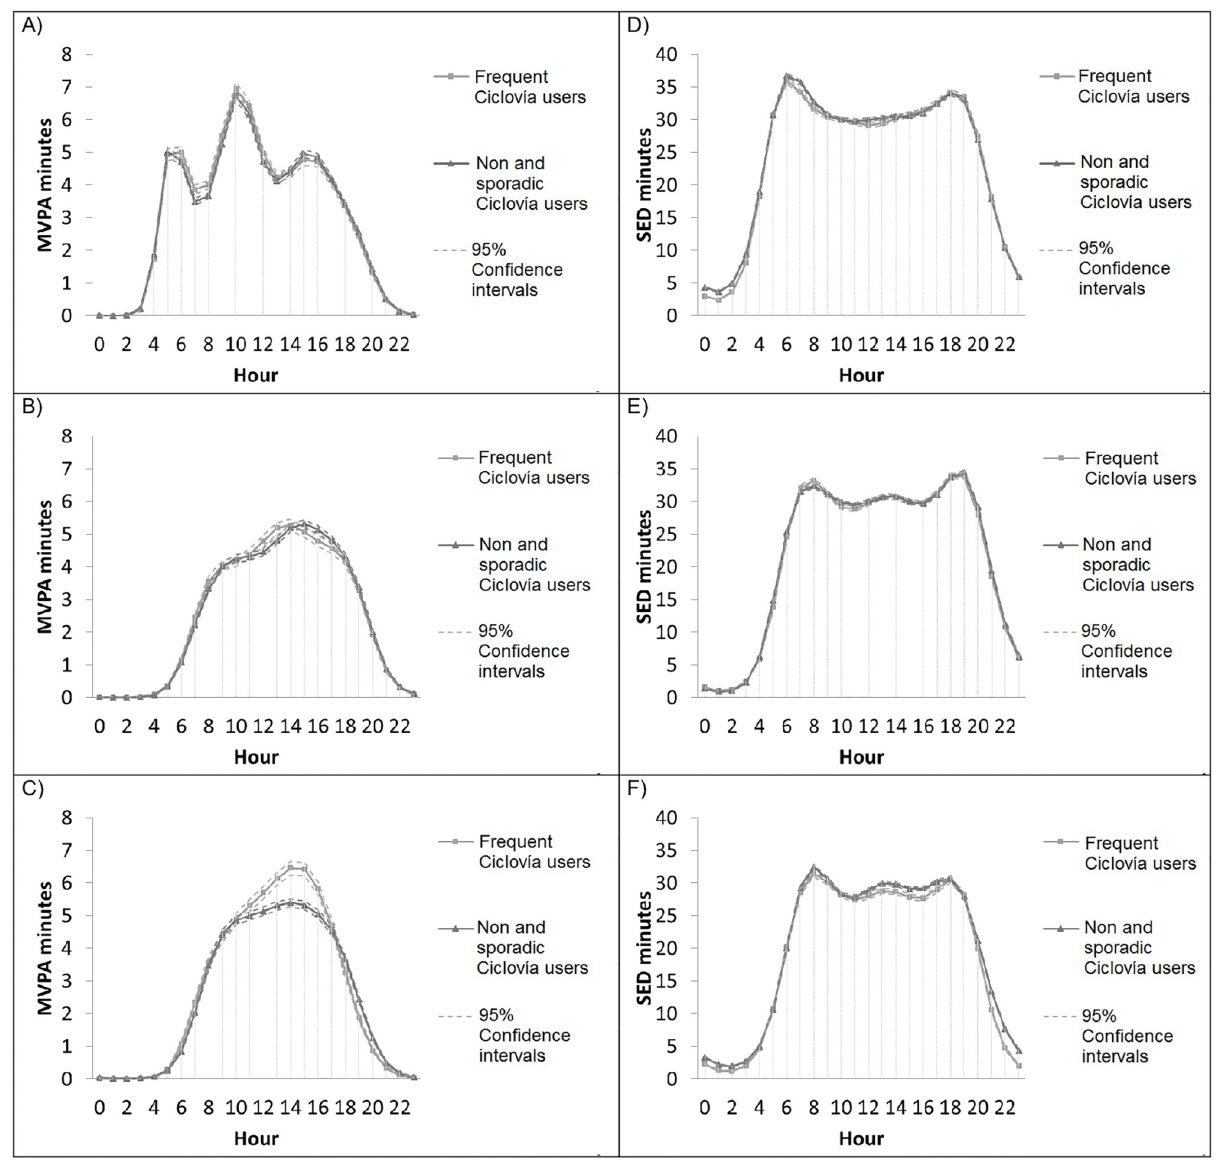
Fig 2. Predictive minutes of moderate-to-vigorous physical activity (MVPA) and sedentary time (SED) for frequent users vs sporadic and nonusers of Ciclovı´a. A) MVPA minutes on weekdays, B) MVPA minutes on Saturday, C) MVPA minutes on Sunday, D) SED minutes on